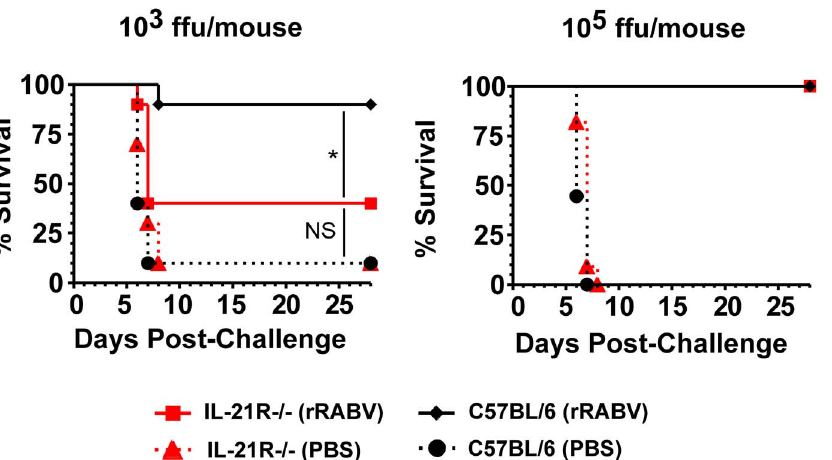
Figure 3. IL-21 signaling is important for protection against RABV challenge after low-dose vaccination. Immunized (Figure 1) and challenged (Figure 2) mice were monitored daily for 28 days post-challenge for clinical signs of rabies and euthanized at the first neurological symptoms of RABV infection (10 3 ffu/mouse left panel; 10 5 ffu/mouse, right panel). Kaplan-Meier survival curves were analyzed by the log rank test; *p , 0.05. (N=9–11 mice per group from two independent experiments). (ffu=focus forming